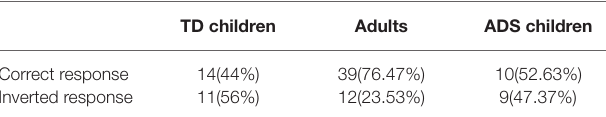
TABLE 2 | Correct vs. inverted pattern of responses in relation to age (left) and in relation to Development type (right).